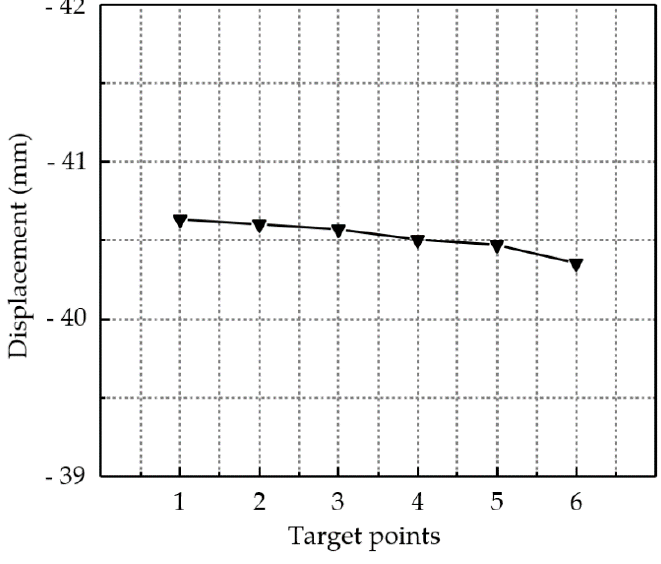
Figure 5. The vertical displacement of target point at 580 s.